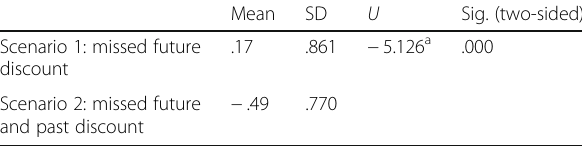
Table 4 Mean regret scores by order of missed opportunity